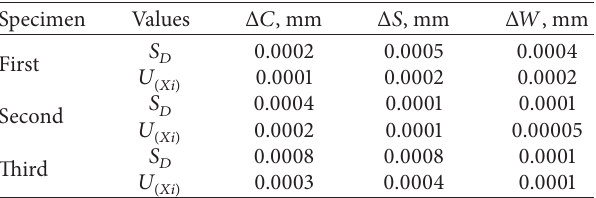
Table 10: The statistical results of tiles specimens using proposed